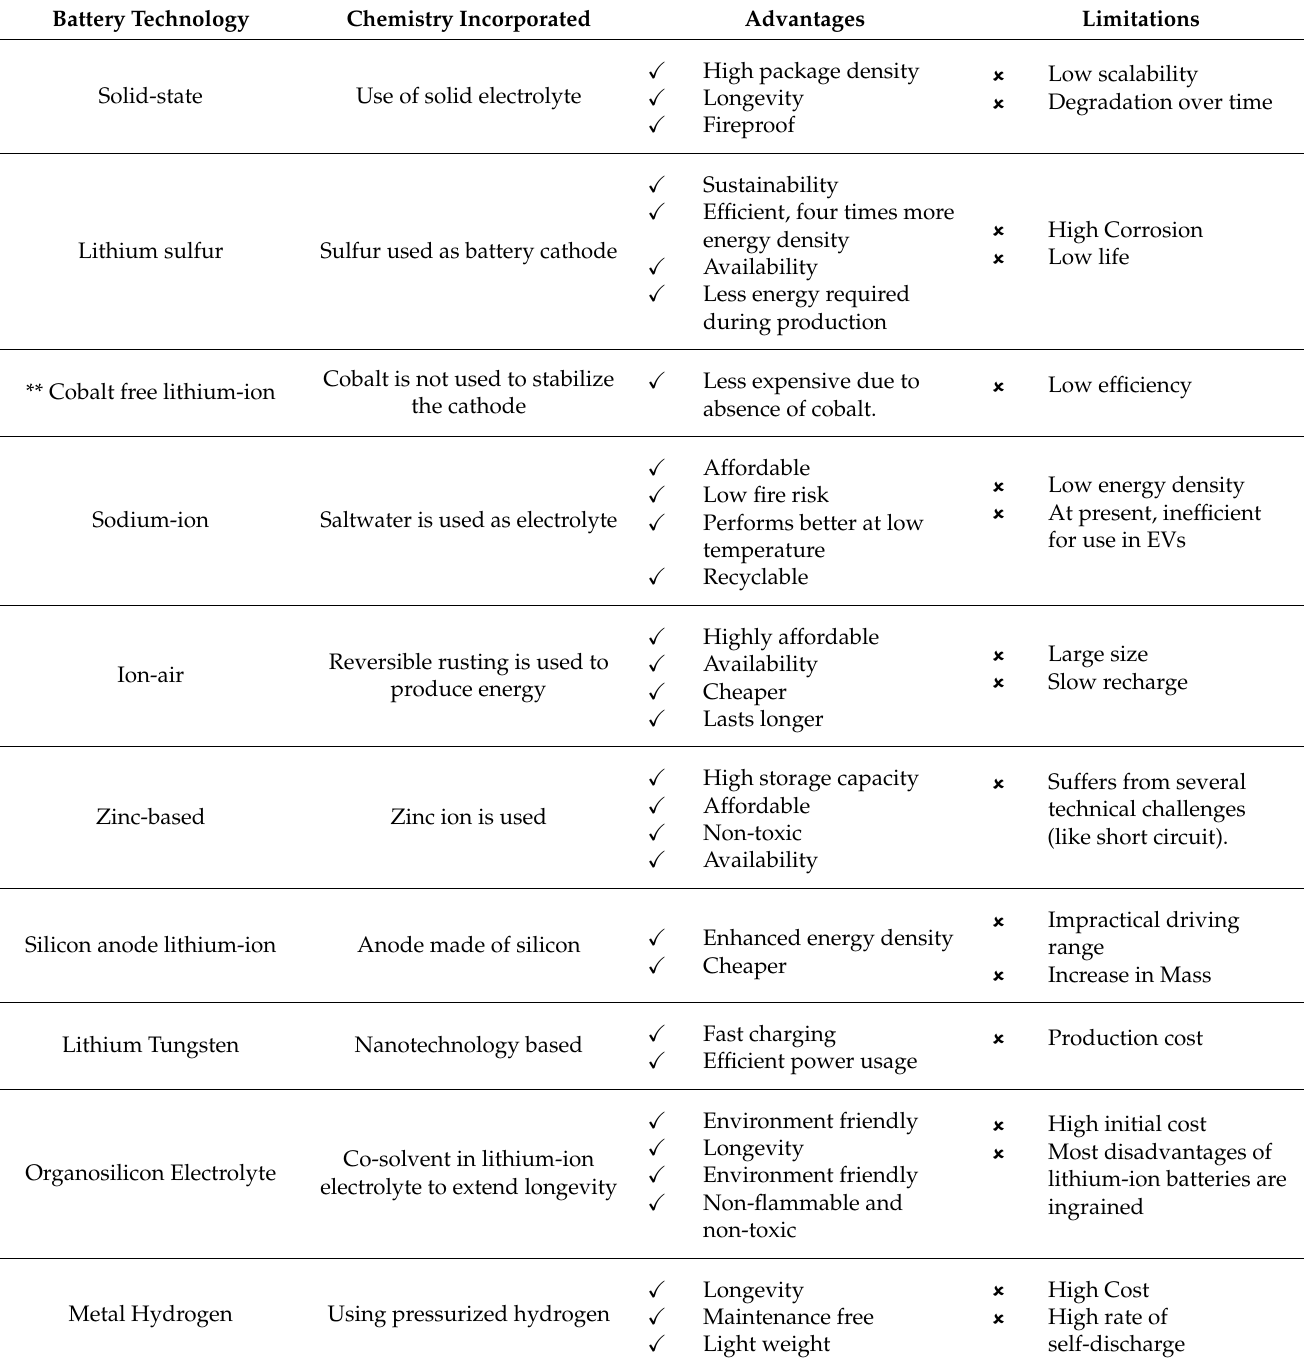
Table 2. Comparative analysis of state-of-the-art battery technologies with Li-ion batteries.